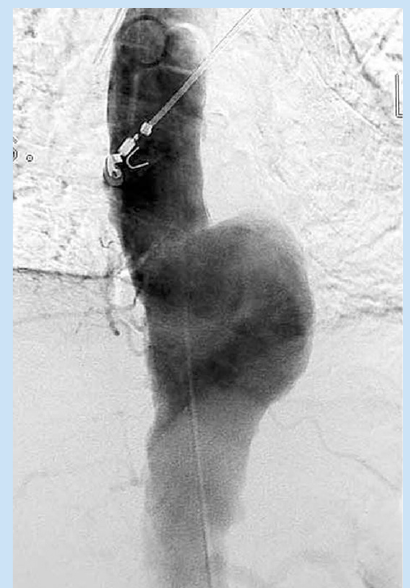
Fig. 1a. Pre-operative angiogram of a 70-year-old male patient with a degenerative aneurysm in the descending thoracic aorta.